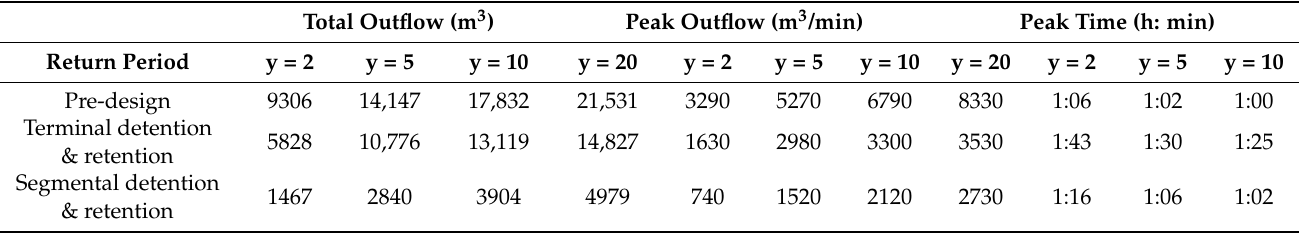
Table 3. Simulations results of the Pre-design Model, Scheme S, and Scheme T under rainfall events of different return periods. Total Outflow (m 3 ) Peak Outflow (m 3